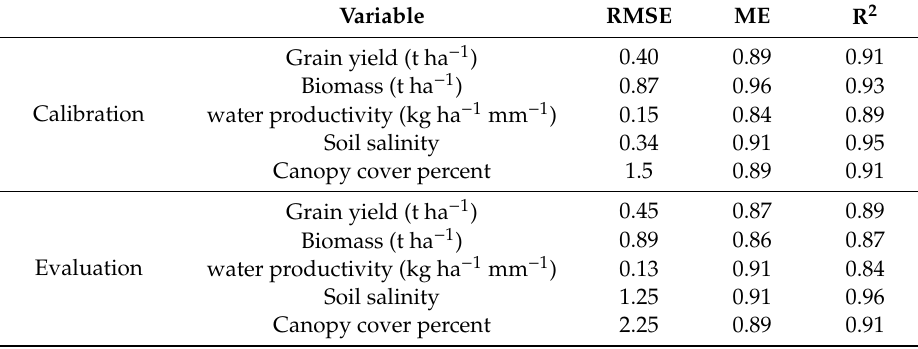
Table 5. Statistical indices values for di ff erent parameters obtained for model calibration. Variable RMSE ME R 2